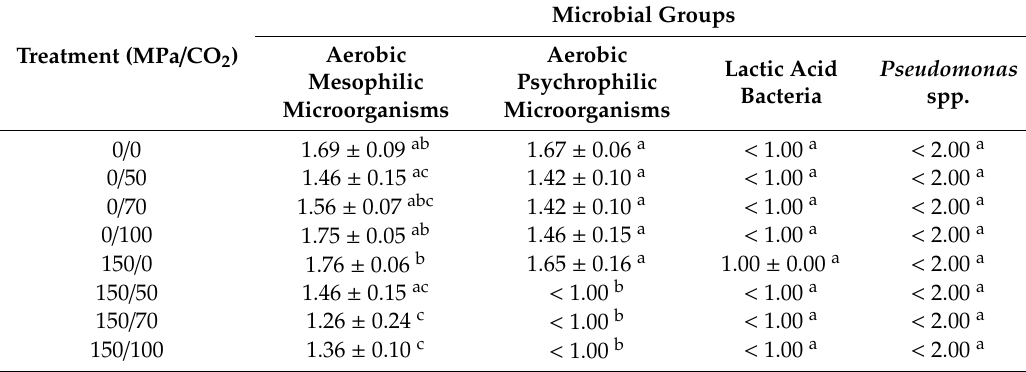
Table 5. E ff ect of treatment on initial counts of studied microbial populations (log CFU / g) in coho salmon